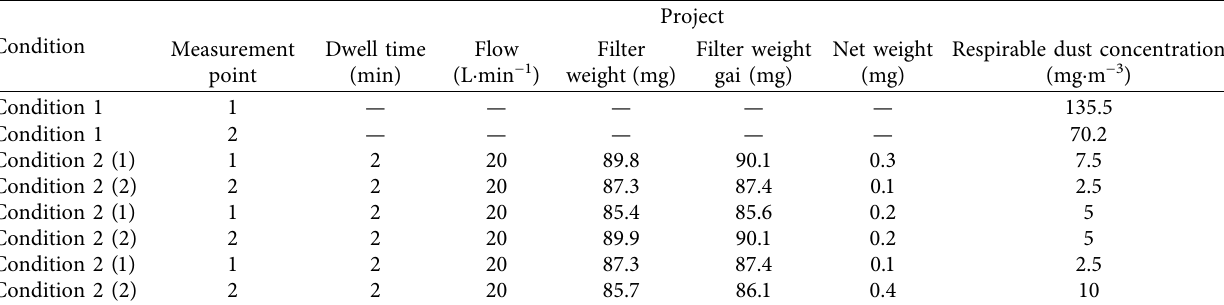
Table 3: Sampling concentration of respirable dust.